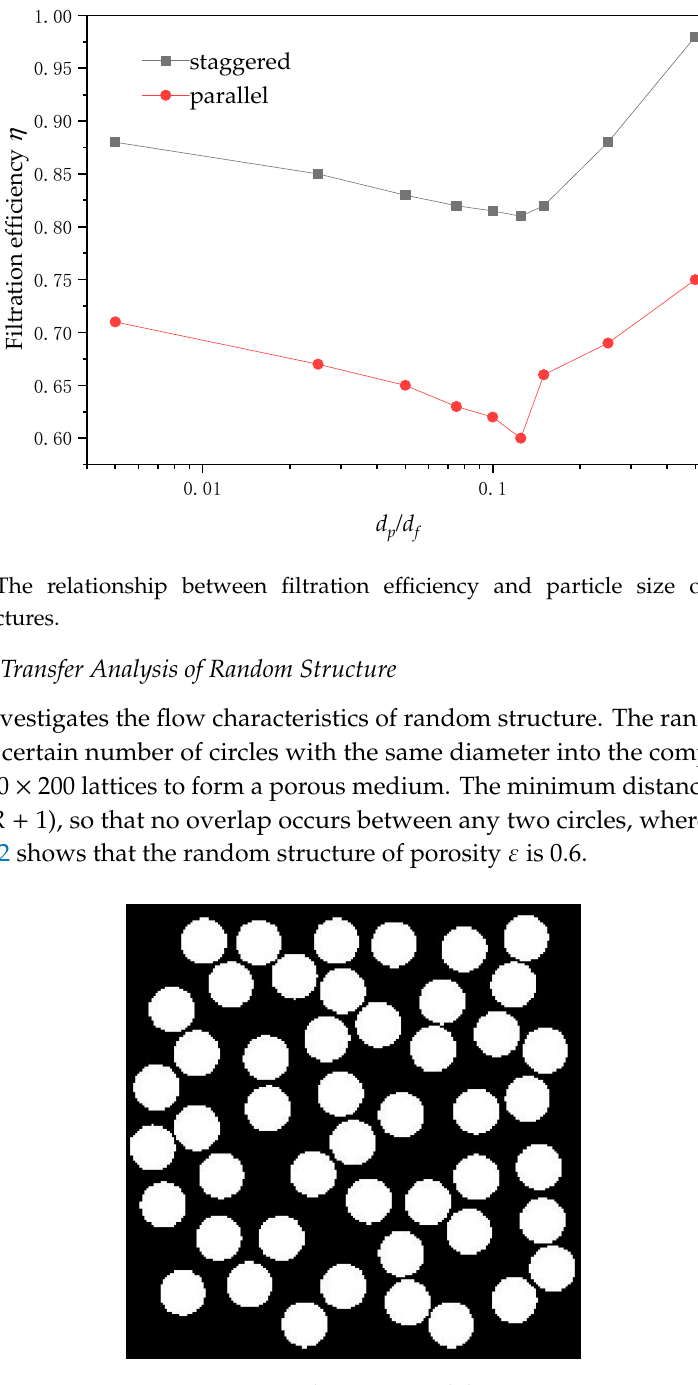
Figure 22. Random structural diagram.